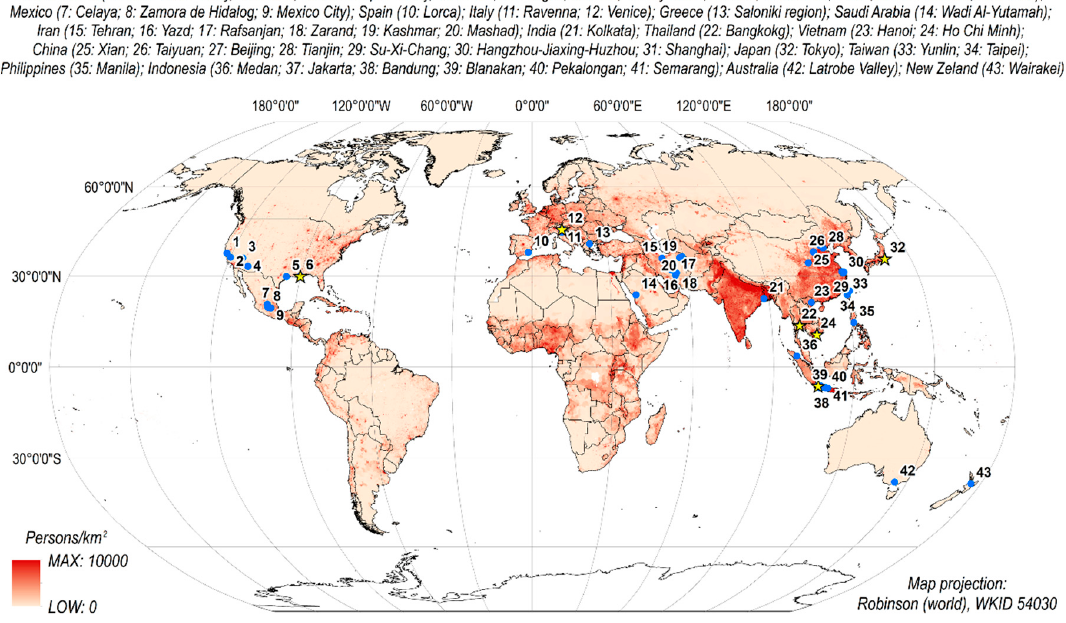
Figure 1. Main areas of the world where anthropogenic land subsidence has been induced by over-exploitation of groundwater (blue dots; source of data [11,48]). Yellow stars indicate coastal areas that are prone to the increased risk of flooding. Note, these are mainly located in densely populated areas of South-East Asia (source of data [8,49]).